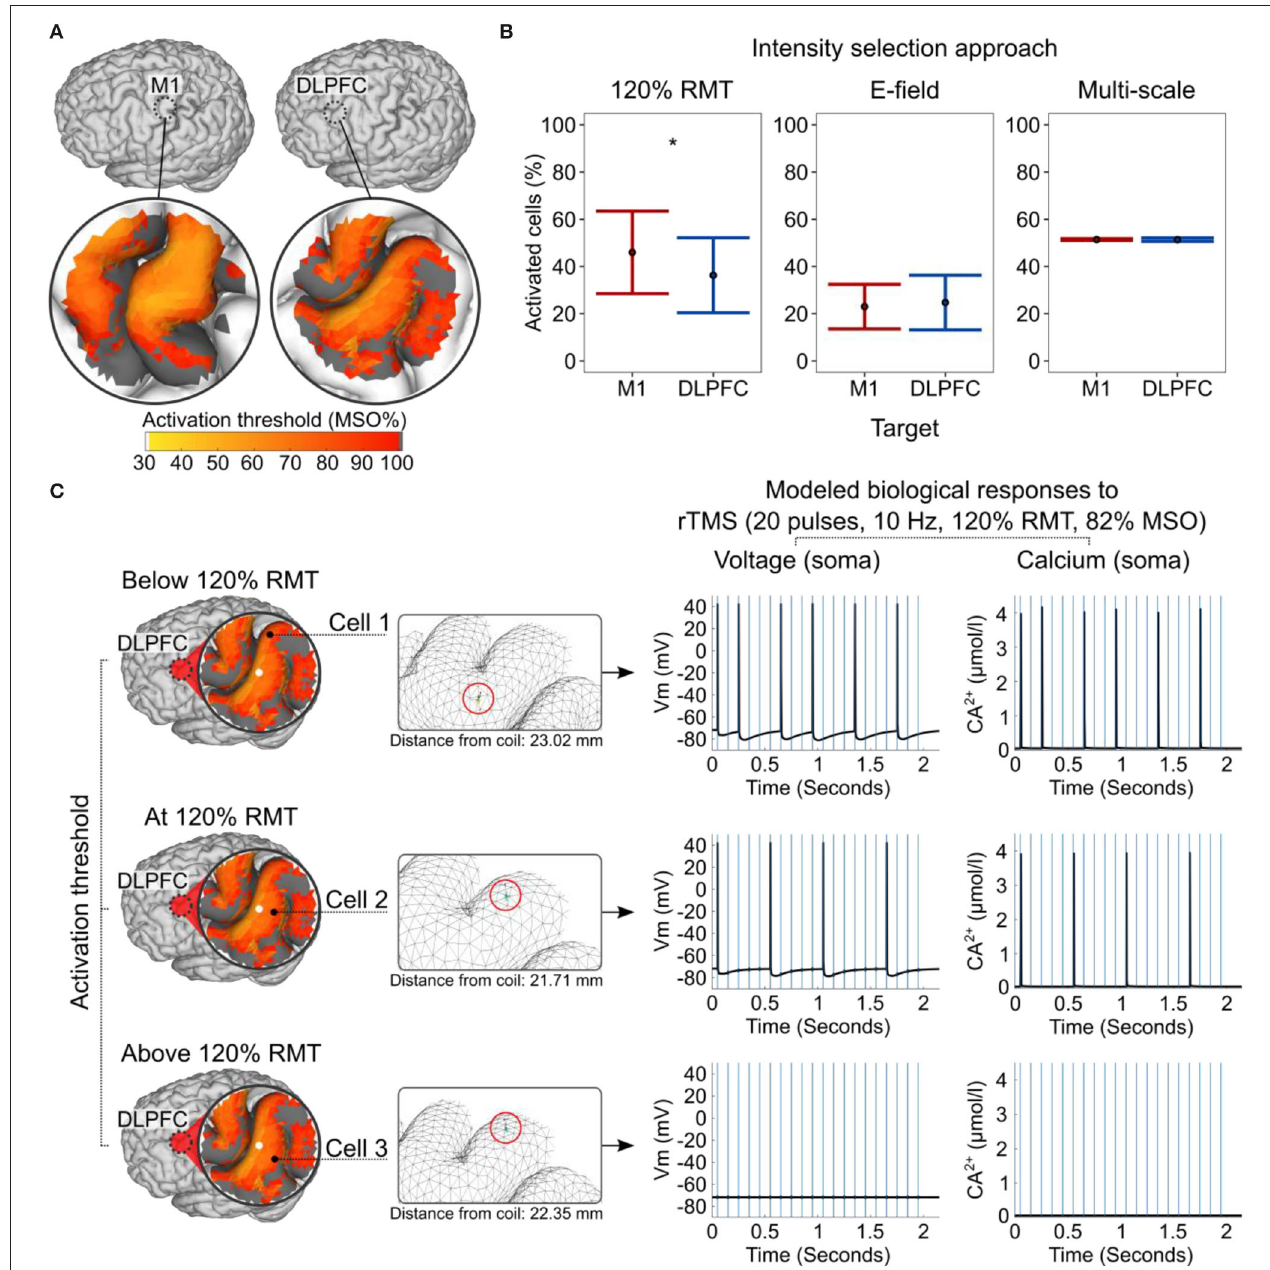
FIGURE 4 | Modeled subcellular/cellular responses to single-pulse TMS and rTMS. (A) The activation threshold is expressed in MSO% of cells produced by single-pulse TMS and shown in an example participant (ID = 2). Dark gray color corresponds to an activation threshold above 100% MSO. (B) Percentage of activated cells produced by the different intensity selection approaches at the group level. (C) Concurrent biological responses to 10Hz rTMS at 120% of RMT (82% MSO) in the DLPFC, depending on the cells’ activation thresholds and locations within the cortical folding shown in an example participant (ID = 2). A white circle indicates the coil center projected on gray matter surface. The mesh insets (in the middle) are rotated for better cell visualization. Red circles in mesh insets highlight cell locations. Blue vertical lines (right) indicate the timing of rTMS pulses and the black line shows the modeled neuronal response. DLPFC, dorsolateral prefrontal cortex; M1, primary motor cortex; MSO%, maximum stimulator output percent; RMT, resting motor threshold. Asterisks indicate a significant effect of factor cortical